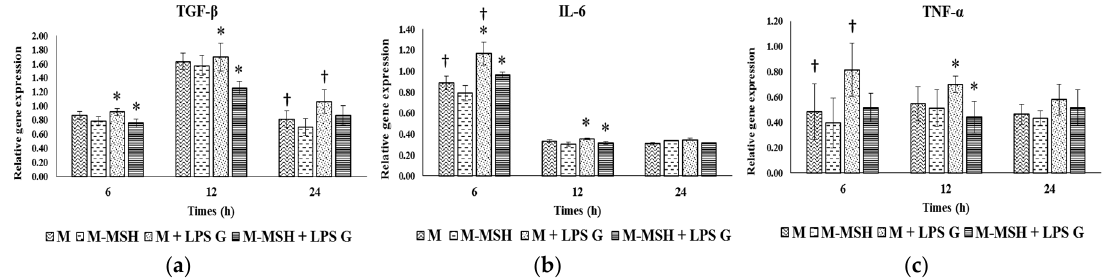
Figure 9. Gene expression of TGF ‐β ( a ); IL ‐ 6 ( b ); and TNF ‐α ( c ) in fibroblast cells with PCL membrane. Relative mRNA levels were analyzed by real ‐ time RT ‐ PCR for IL ‐ 6, TGF ‐β and TNF ‐α in EC after 6, 12 and 24 h on PCL culture ( n = 4). Data are expressed as mean ± SD. †: di ff erence between non ‐ stimulated and stimulated cells, p < 0.05; *: difference between stimulated cells with or without PGA ‐α‐ MSH, p < 0.05.